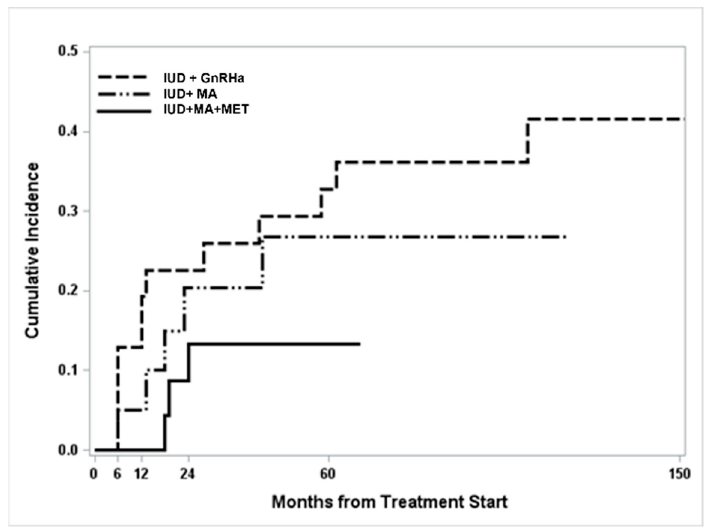
Figure 1. Cumulative incidence curves for relapse according to treatment. Furthermore, there was a not-significant increasing trend of relapse CI over time in women who did not have pregnancy after FST, whereas post-treatment pregnancy did not affect CI ( p = 0.19) (Figure